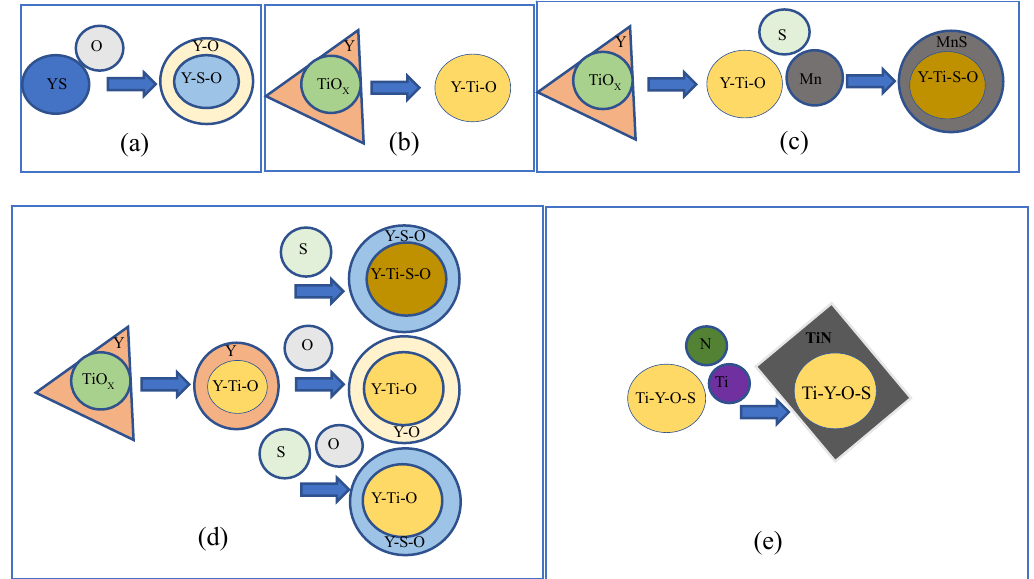
Figure 3. The line scanning results of the typical inclusions in the steel alloys: ( a ) C2, ( b ) C3, and ( c ) C4.